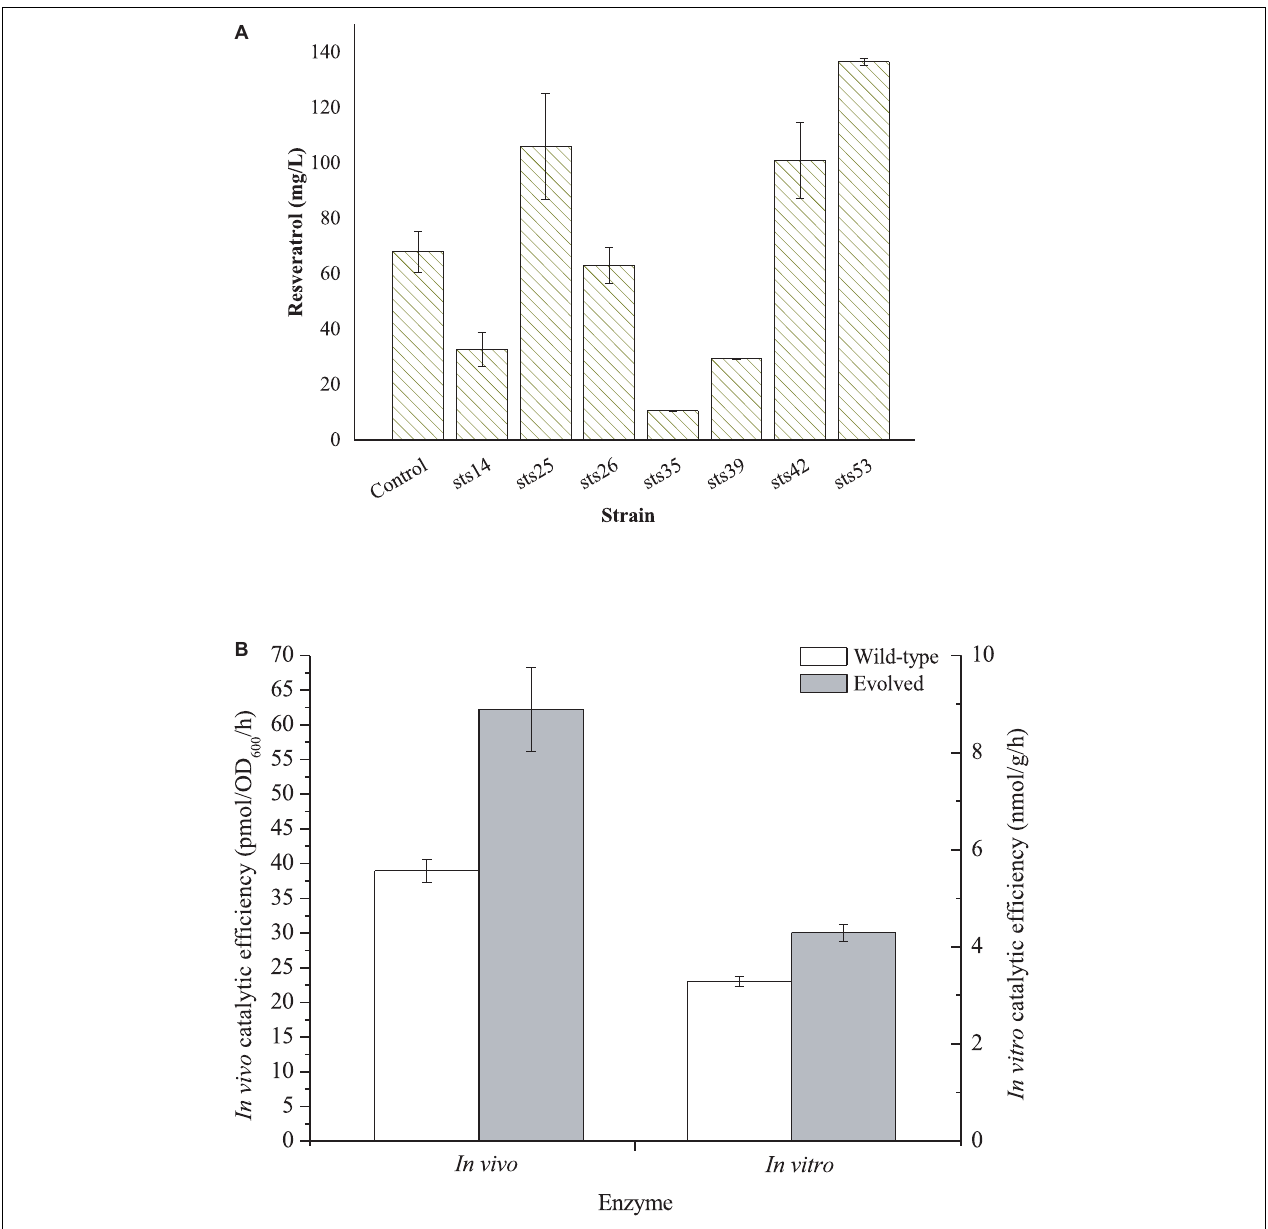
FIGURE 3 | (A) De novo resveratrol production by E. coli TYR-30 harboring the mutant plasmids of pZBK-sts and p214C. E. coli TYR-30 harboring pZBK-sts and p214C was set as the control. (B) In vivo and In vitro catalytic efficiency of the evolved STS and its wild-type enzyme. In vivo activity was defined as the resveratrol forming rate of the whole resting cells and In vitro activity was defined as the resveratrol forming rate of the crude extract. The data represent means of three replicates and error bars represent standard deviations.